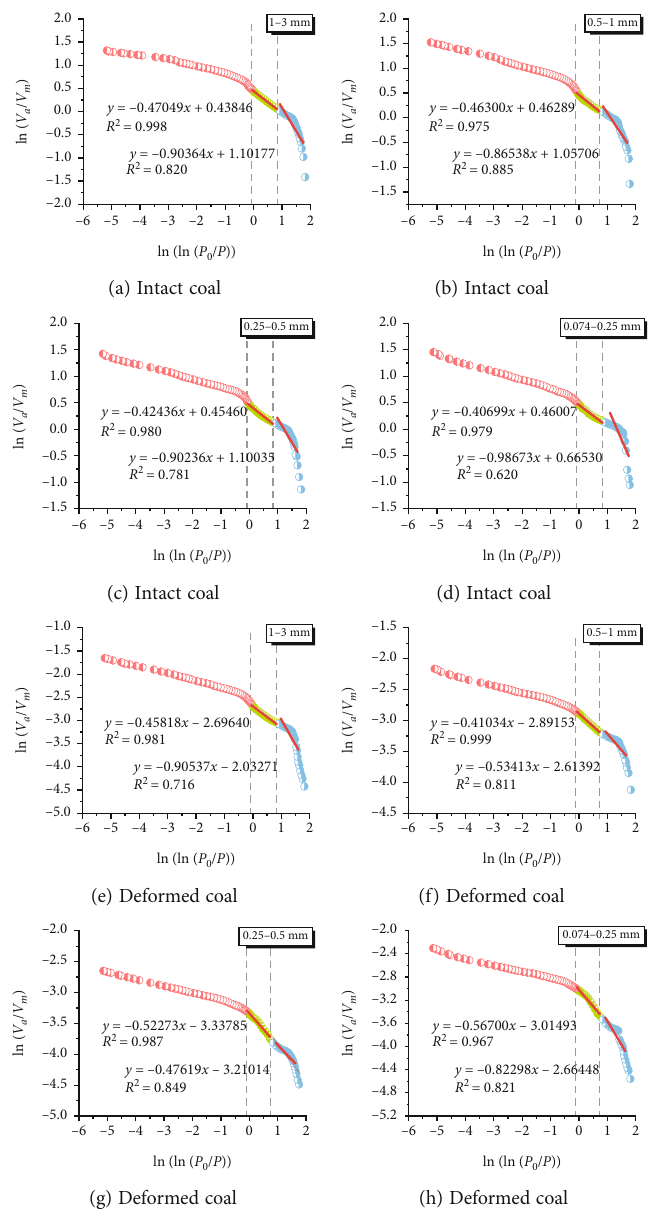
Figure 9: Fractal dimensions of minipores and micropores. Table 4: Fractal dimensions of coal